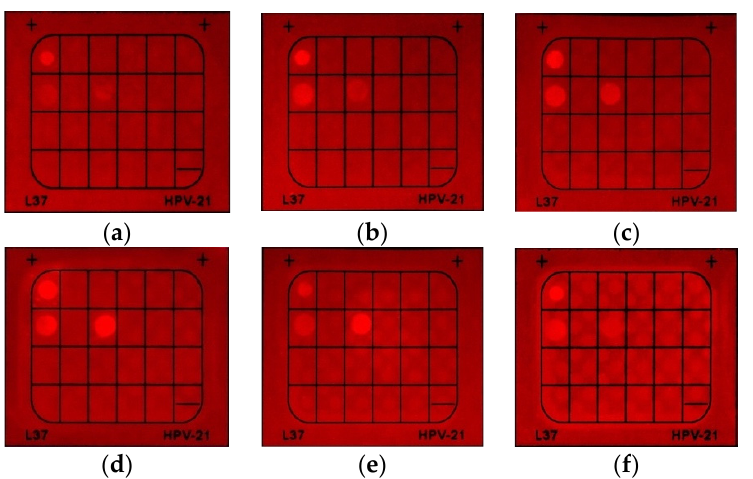
Figure 6. Concentration screening of HCAP, showing ( a ) 10 μ M, ( b ) 20 μ M, ( c ) 50 μ M, ( d ) 0.1 mM, ( e ) 0.2 mM, and ( f ) 0.5 mM. Probe incubation time: 5 min. PCR cycles: 40. Photos were taken under a 395 nm UV lamp with a band-pass filter 600–700 nm.